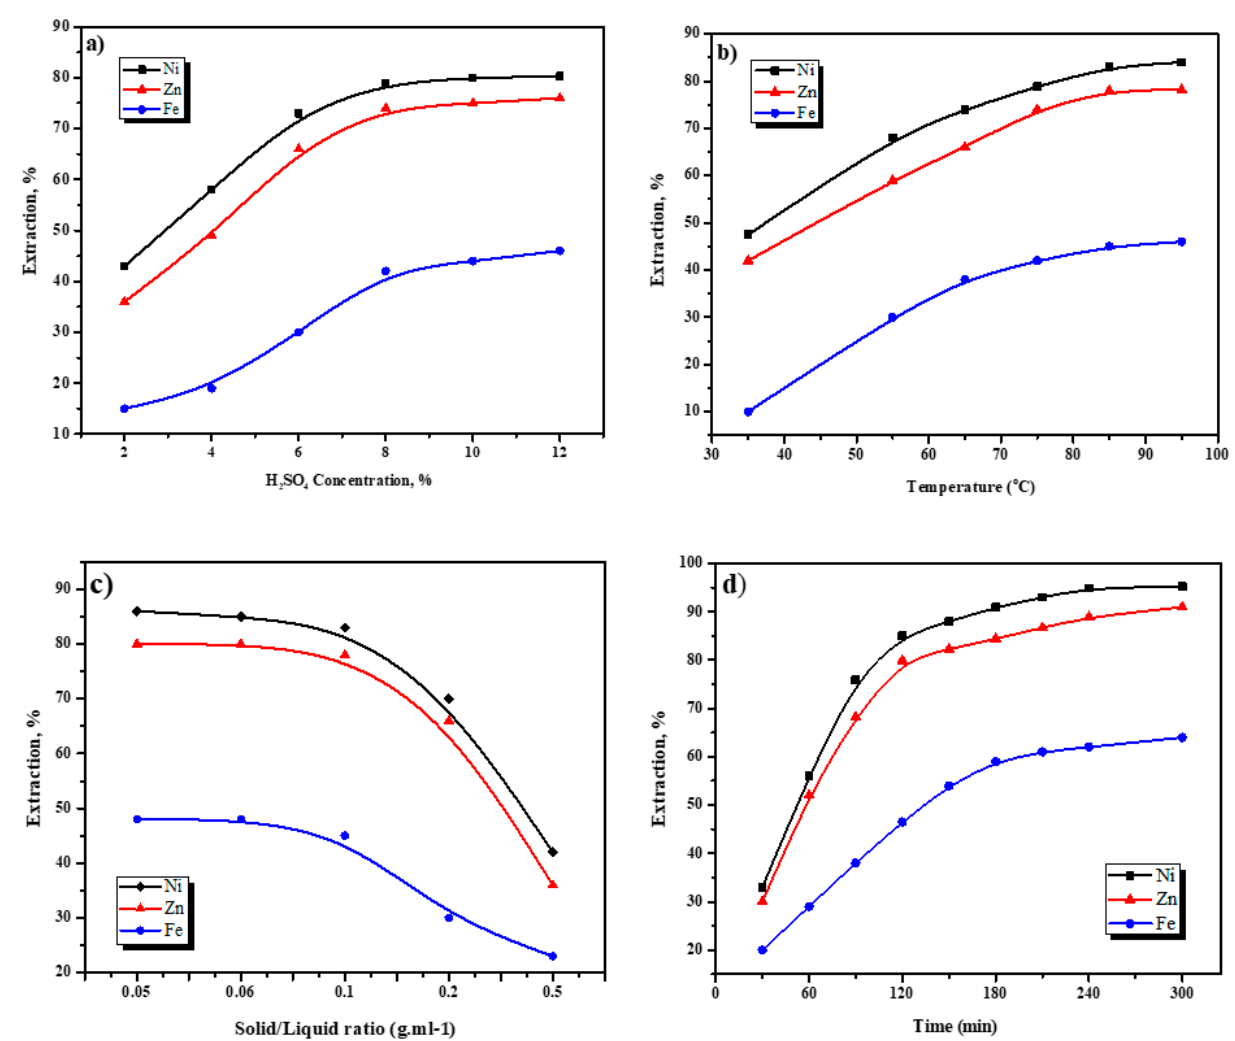
Figure 4. Effect of H 2 SO 4 acid concentration ( a ), leaching temperature ( b ), solid/liquid ratio ( c ) and leaching time ( d ) on Ni, Zn and Fe extraction.